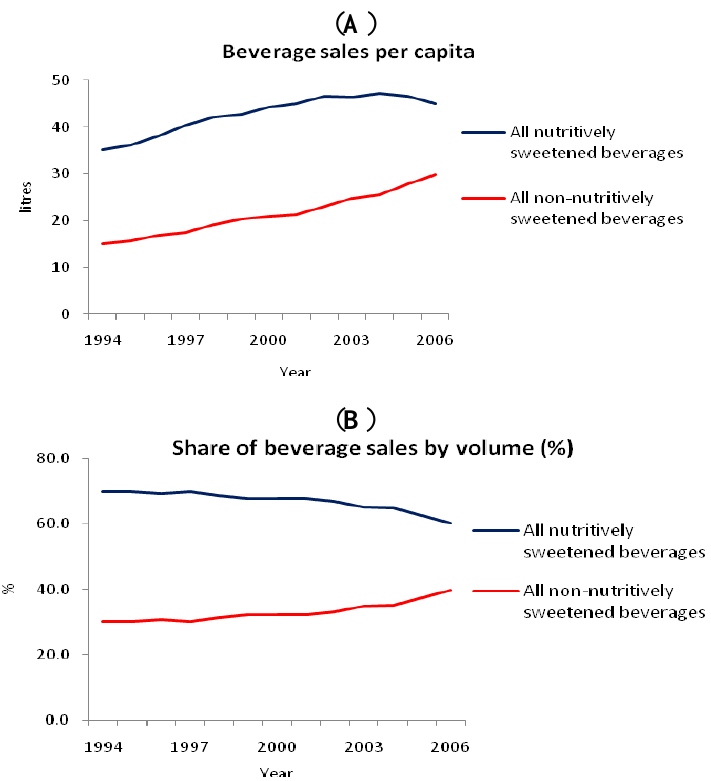
Figure 5. Time trends in sales of nutritively sweetened beverages and non-nutritively sweetened beverages in grocery stores, expressed as ( A ) per capita volume sold in liters and as ( B ) a percentage of total volume sold [15,28–30].